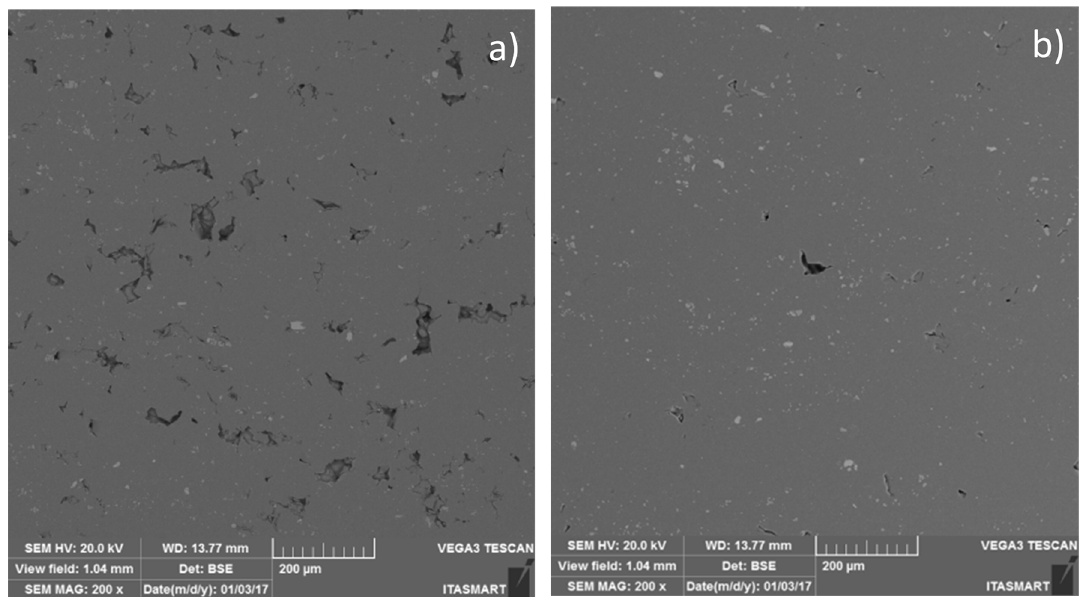
Figure 17. SEM images of domes processed: a) without back-pressure; and b) with 10 bar of back-pressure, samples extracted from the positions of (φ=45º; θ=0º), the rolling plane is parallel to the page and the rolling direction is horizontal to the page. the stress applied, that is the same as rolling direction for this samples, it corroborates with discussions from Figure